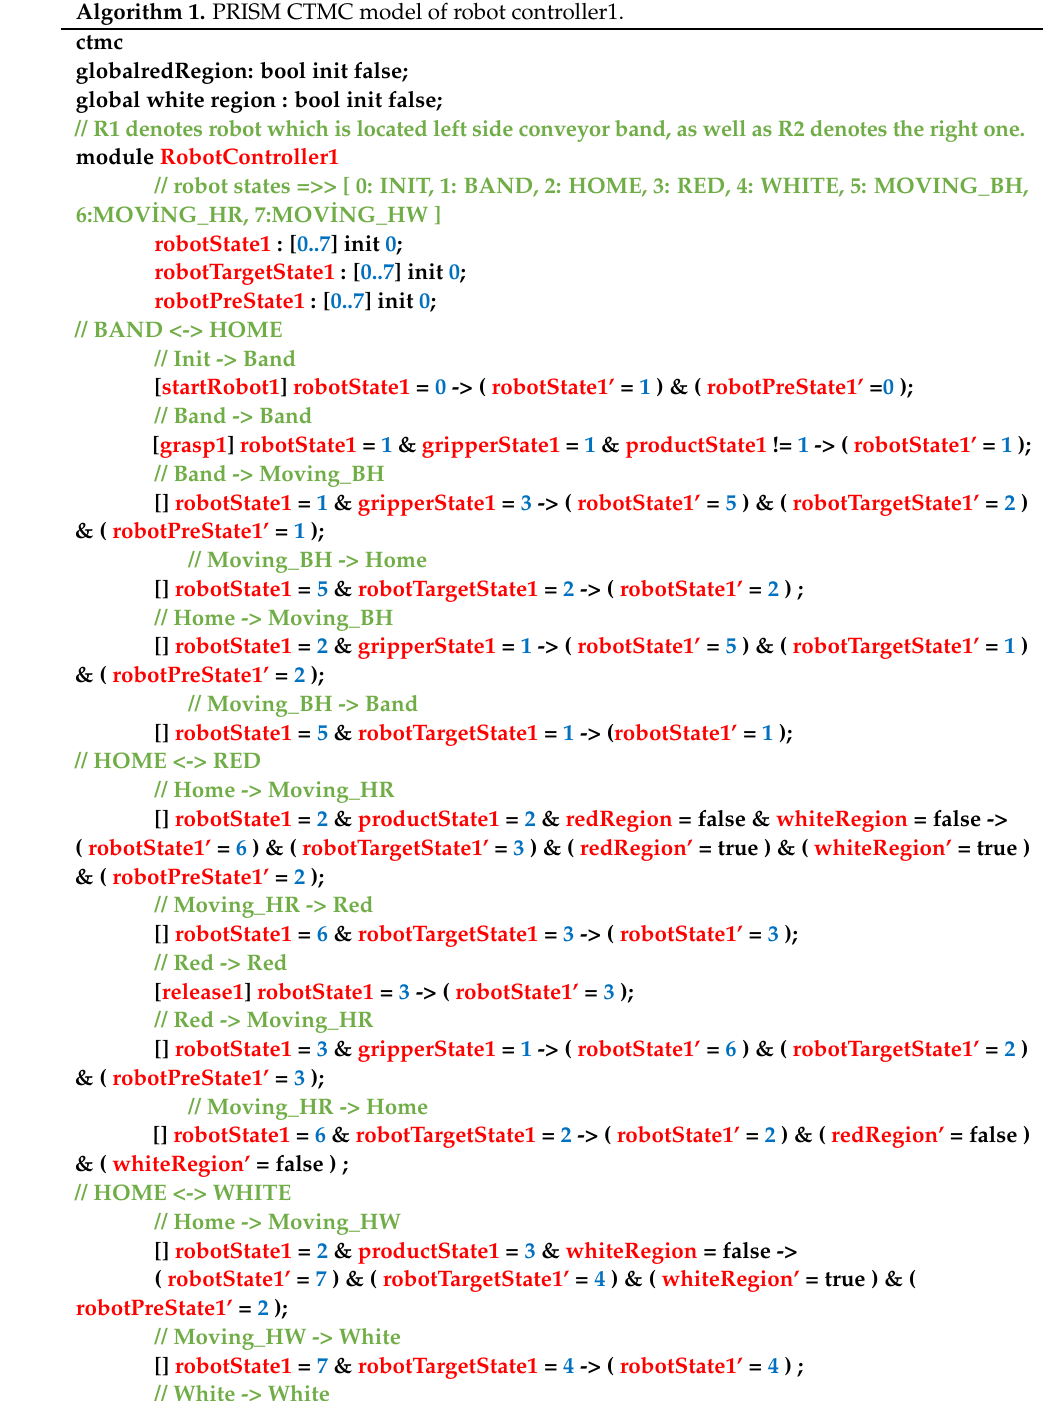
Algorithm 1. PRISM CTMC model of robot